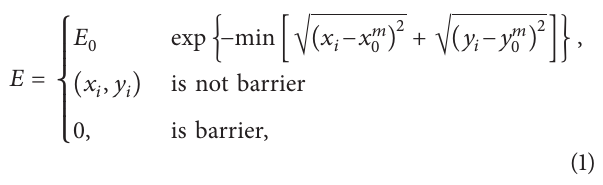
where 𝛼 ∈ [0, ∞] is rigidity coefficient indicating the hurt degree caused by barriers and